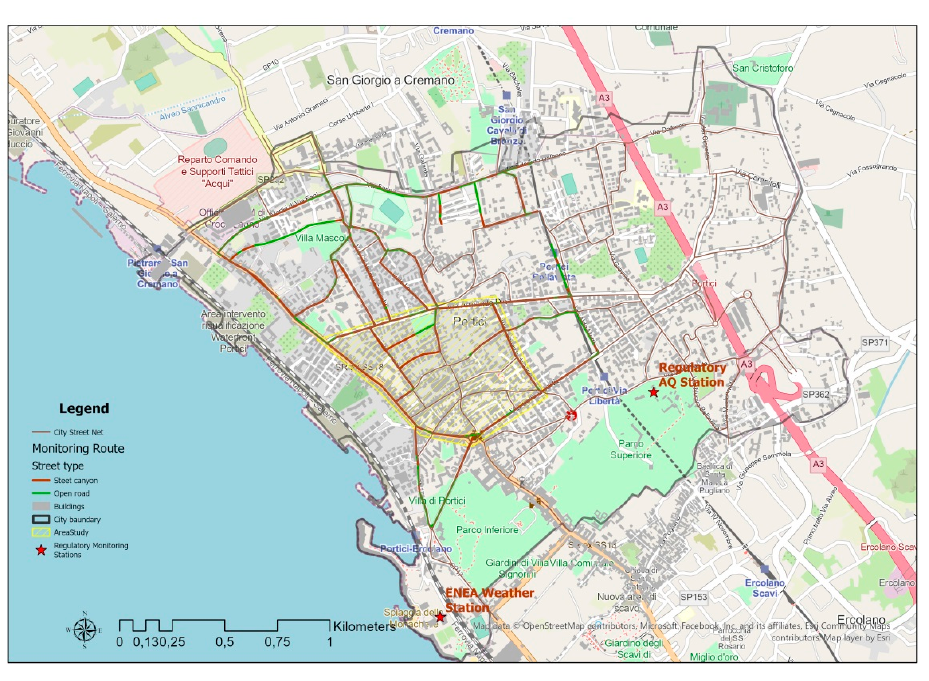
Figure 1. Map of the City of Portici. The map includes: the weather station (by ENEA RC Portici) and the regulatory air quality monitoring station located in the city (both represented in red stars); the area study (represented in the yellow area) and the urban street network classified as street canyon (red lines) and open street (green